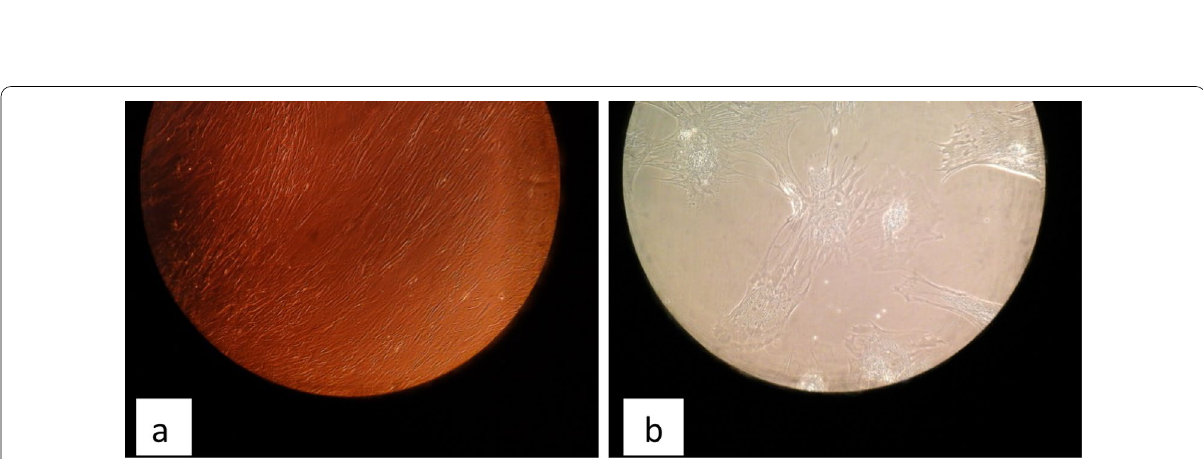
Fig. 4 Whole umbilical cord-derived stem cells were plated to obtain a growth curve: a After 3 weeks 100% confluent in DMEM-F-12 medium with